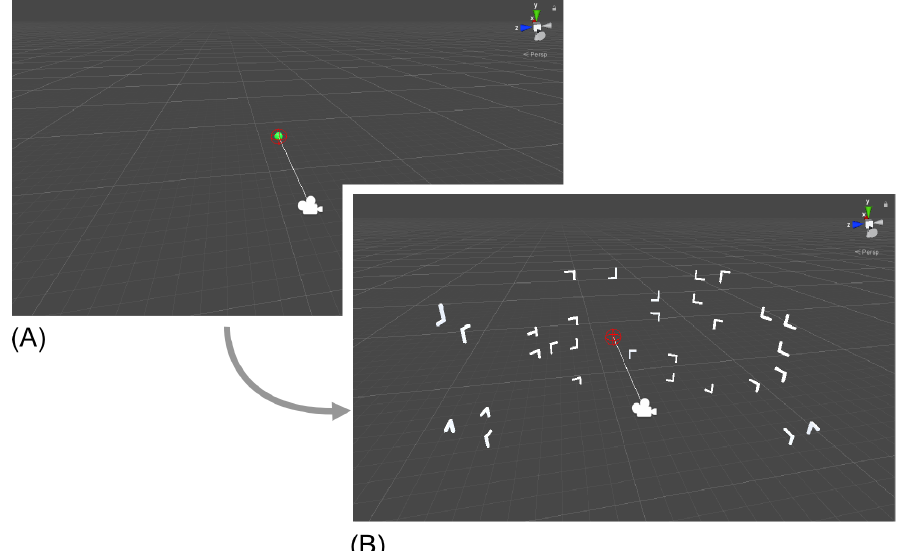
Figure 1. An overview from the “scene view” in Unity Engine. The camera icon is the visualization of the participants head. The red sphere and the corresponding vector indicate the orientation of the field of view (FOV) and were invisible for the participant. ( A ) Checking the head position with the help of a fixation object. If the red sphere aligned with the green fixation object a new trial was started. ( B ) An overview of an exemplary search